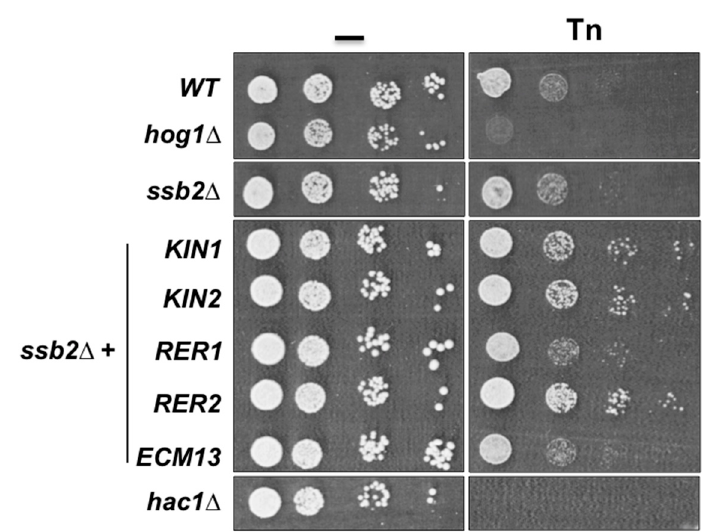
Figure 6. Effect of the inactivation of SSB2 and overexpression of suppressor genes on Tn sensitivity. The single ssb2 Δ mutant and transformants carrying the indicated genes were tested in 1.0 μ g/mL of Tn as indicated in figure legend 2B. Overexpression was achieved by cloning the indicated genes in the multicopy plasmid YEp352 under the control of their own promoter. Serial dilution assay was performed as indicated in figure legend 2B. Plates were incubated at 30 °C for 72 h and scanned.